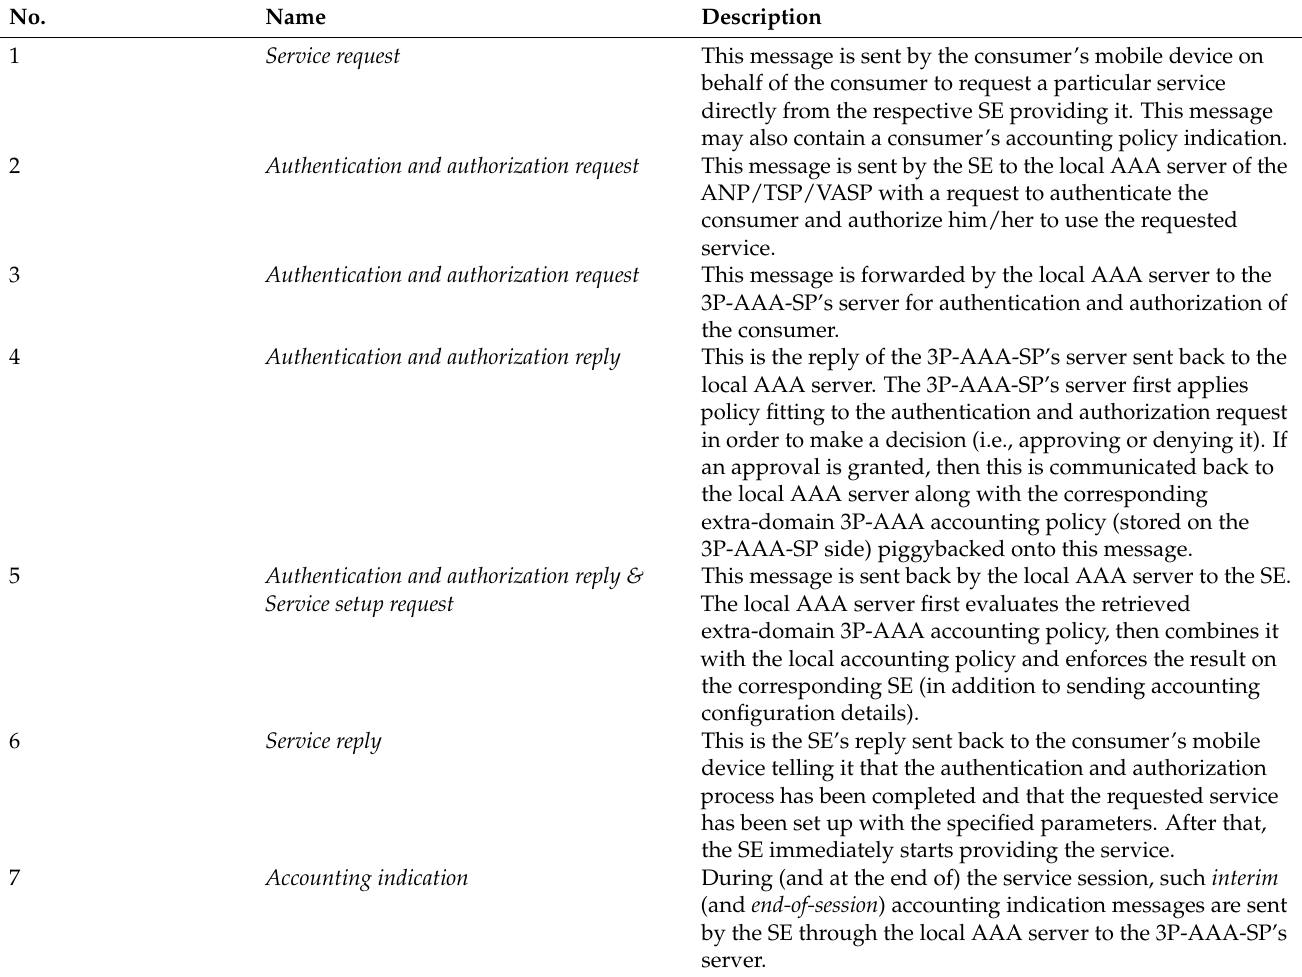
Table 3. Main signaling messages of the pull authorization